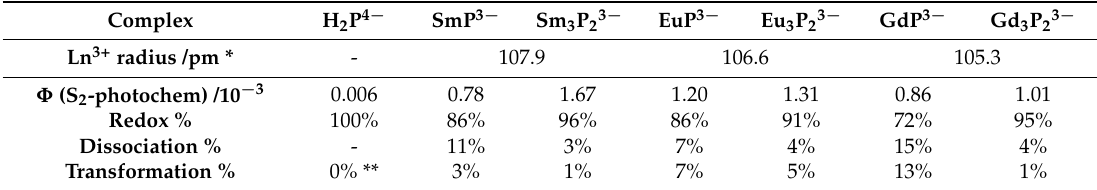
Table 3. Quantum yields for the investigated lanthanide(III) porphyrins, NaClO 4 = 0.01 M, c(Ln 3+ )